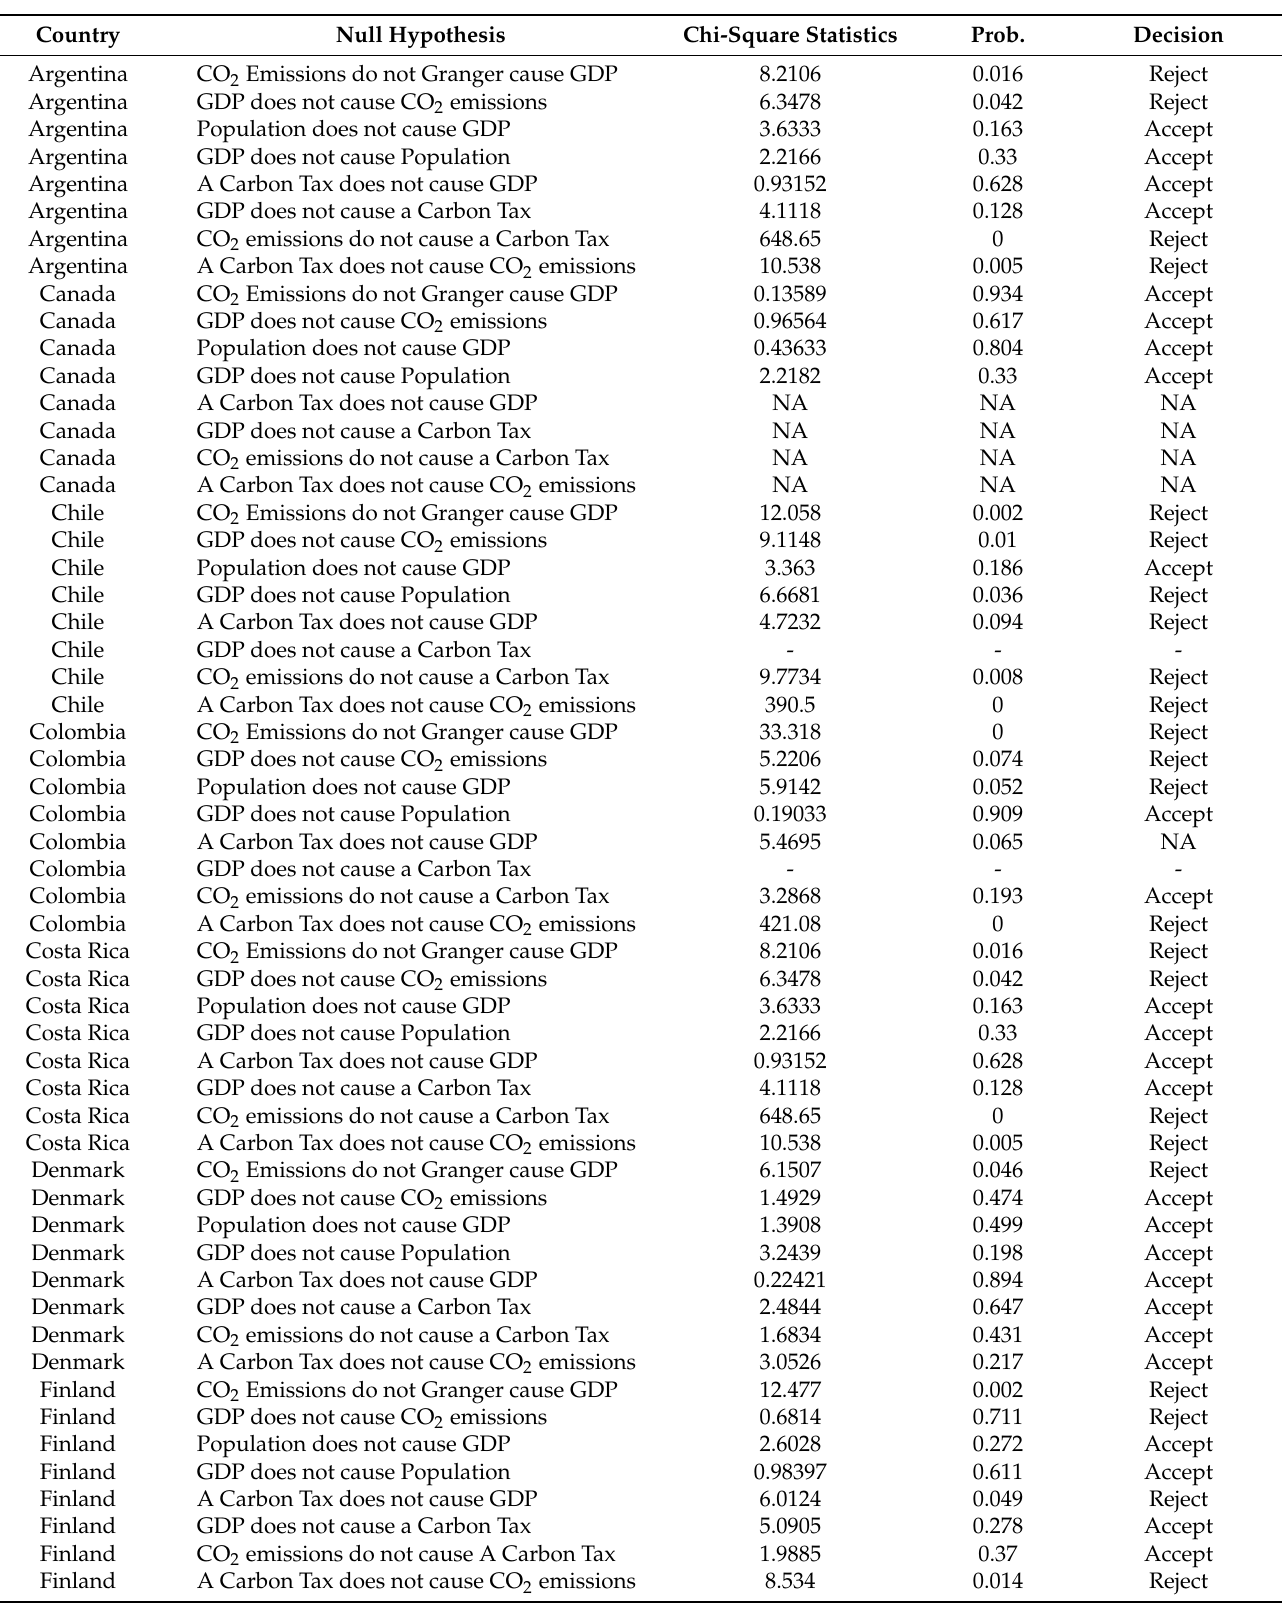
Table A2. Country-wise results of Granger causality